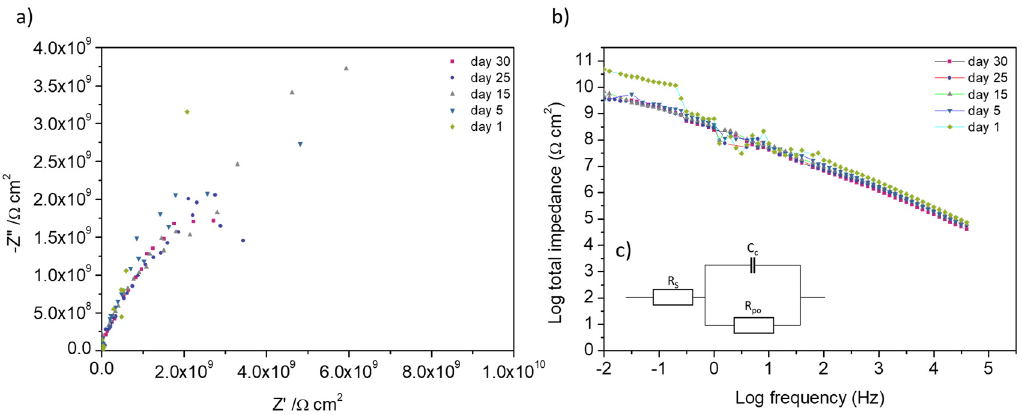
Figure 7. ( a ) Nyquist and ( b ) Bode plot of electrochemical impedance spectroscopy (EIS) measurement for selected days for sample C1 and ( c ) the equivalent circuit. for selected days for sample C1 and ( c ) the equivalent